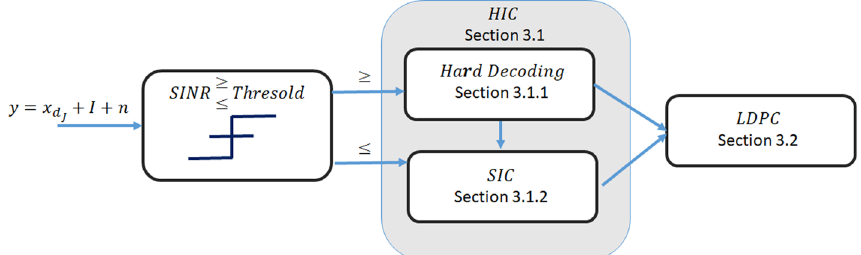
Fig. 4 Joint HIC-Log MPA